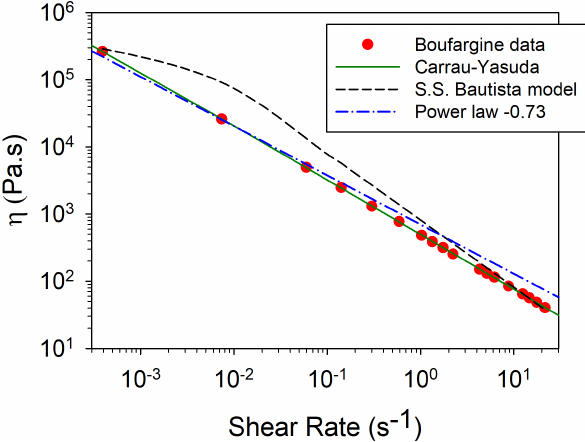
Figure 2: Experimental data of viscosity of polyoxyethylene water solution versus shear rate from Boufarguine et al. [22] compared to predictions using the Carreau-Yasuda model, the steady-state- Bautista et al. model and the power law model with exponent value of − 0.73. Parameters of the Carreau-Yasuda model are provided